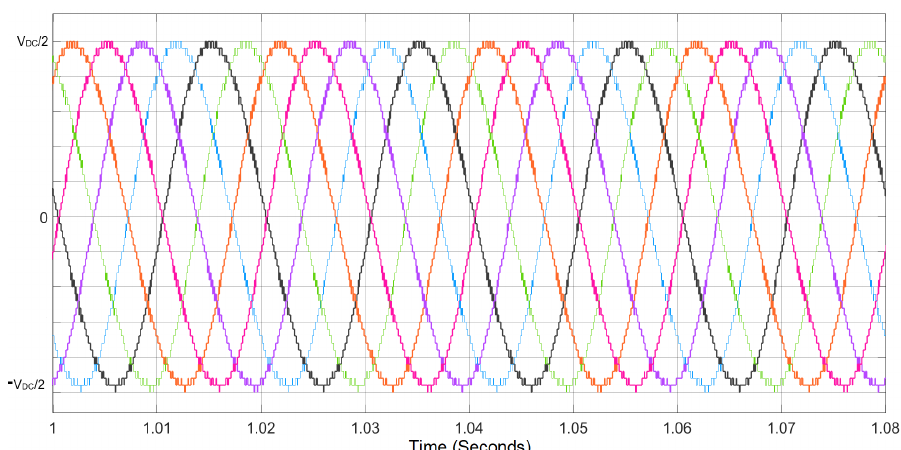
Figure 18. Nearest level modulation signals for MMC.